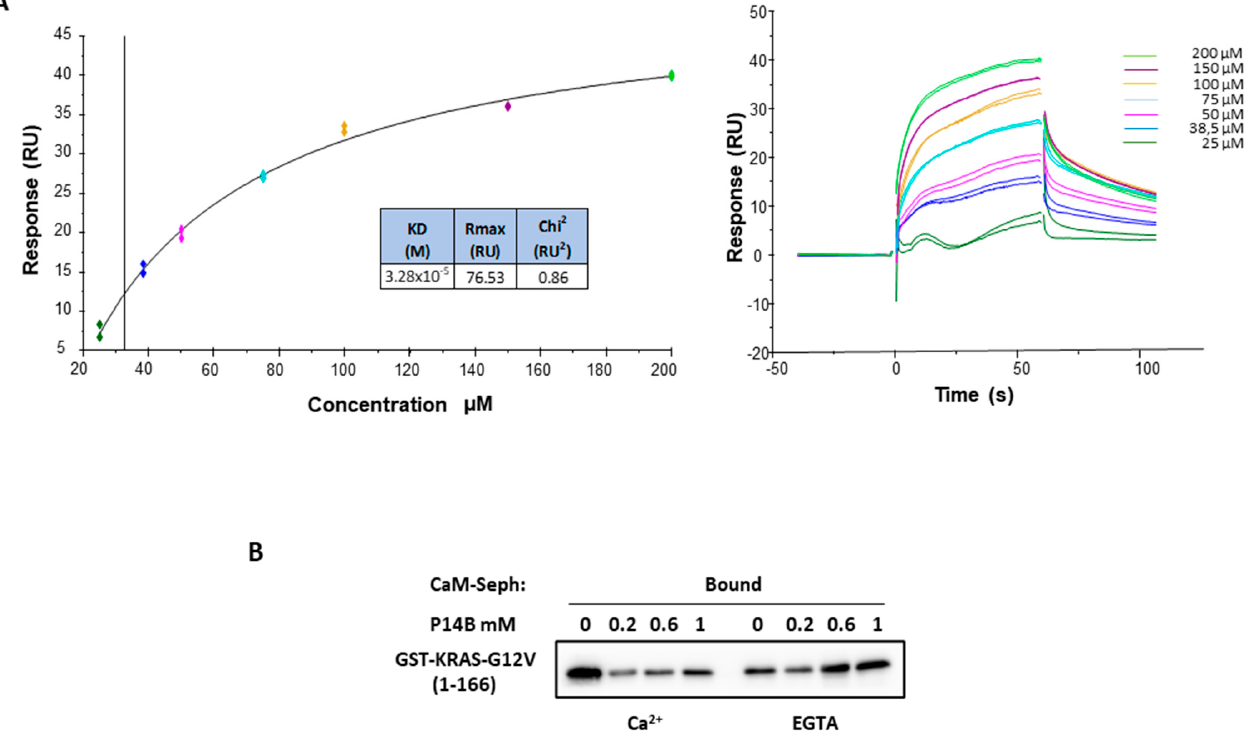
Figure 3. ( A ) Kinetic analysis ( left ) and sensograms ( right ) of the binding of P14B to GST-K-Ras-G12V (1–166) determined by surface plasmon resonance. RU, resonance units. The same code of colors indicated in the kinetic analysis are used in the sensogram to indicate each concentration of P14B ( B ) Competition between P14B and CaM for binding to oncogenic KRAS: CaM-sepharose pulldown assays were performed using GST-KRAS-G12V in the presence of P14B. Ca +2 or EGTA containing buffers indicate specific or non-specific KRAS-G12V binding to CaM, respectively. Bound fractions were analyzed by WB with anti-KRAS specific antibodies.